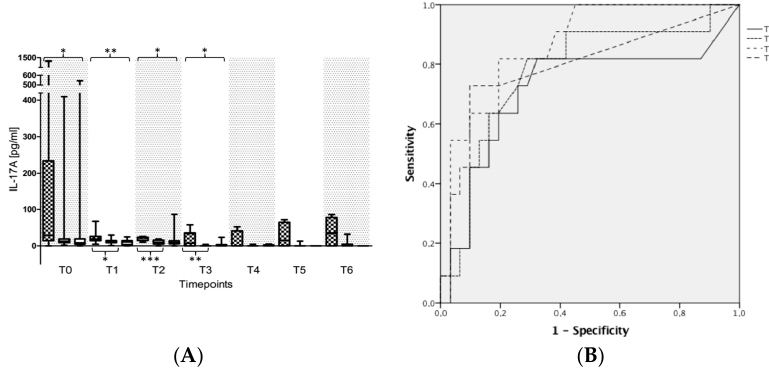
Figure 4. Plasma concentrations of interleukin (IL)-17A in patients with septic shock. Legend: ( A ) Plasma concentrations of IL-17A were measured in patients suffering from septic shock with a fungal infection (grey squared box), a fungal colonization (grey plane box) or without any fungal findings (white box). Plasma samples were collected at the onset of septic shock (T0), and 1 day (T1), 2 days (T2), 7 days (T3), 14 days (T4), 21 days (T5), and 28 days (T6) afterwards. Data in box plots are given as median, 25th percentile, 75th percentile with the 10th as well as 90th percentile at the end of the whiskers. Concerning symbolism and higher orders of significance: * p <0.05, ** p < 0.01, *** p < 0.001; ( B ) Receiver operating characteristic (ROC) analysis with IL-17A in all participating patients at sepsis onset (T0), and 1 day (T1), 2 days (T2) as well as 7 days (T3) afterwards with regard to the prediction of a fungal infection up to day 28. Patients suffering from a fungal infection represented the target group, whereas both, patients with a fungal colonization as well as patients without any fungal isolates served as controls for this ROC-analysis.